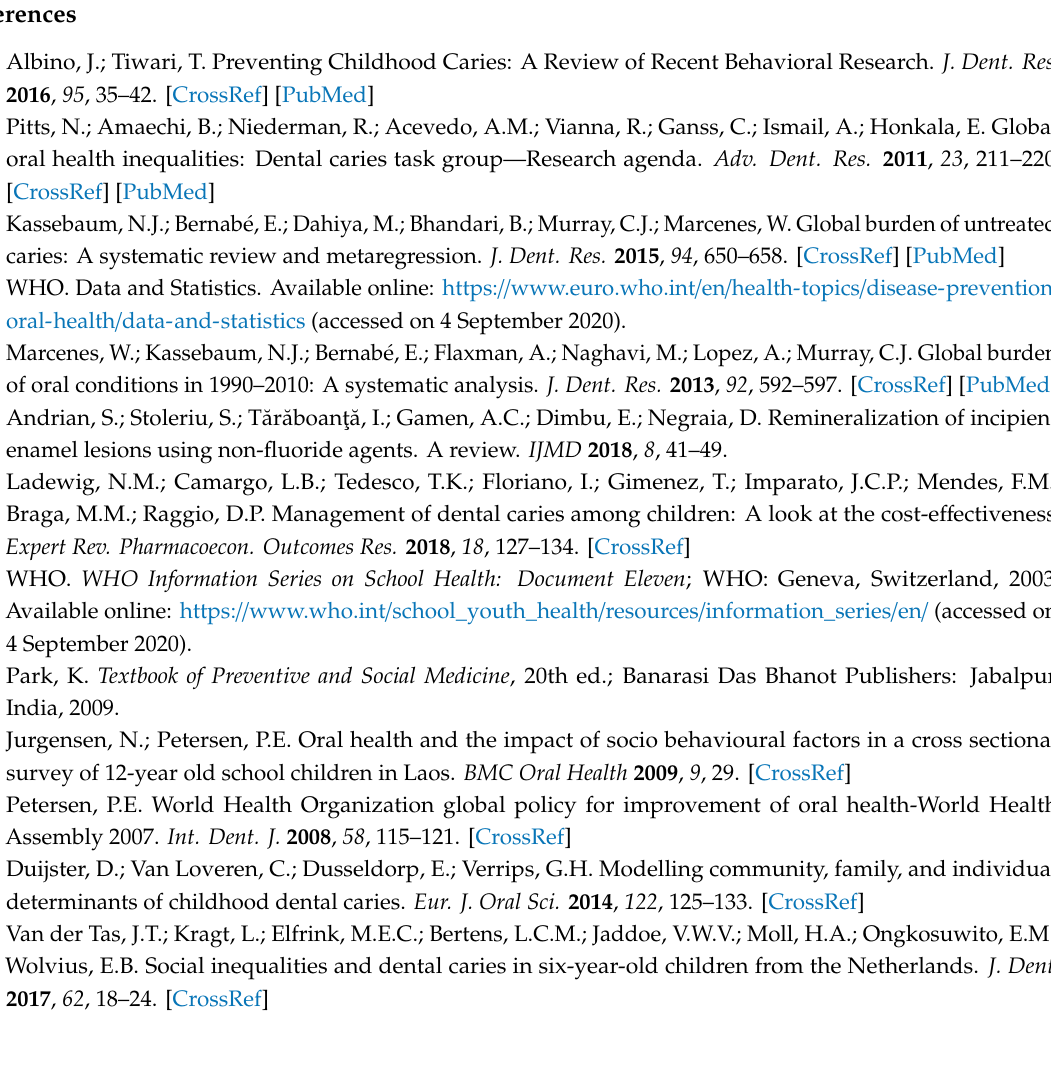
Figure S1: Logistic model analyses for both univariate and adjusted models for disease. Figure S2: Logistic model analyses for both univariate and adjusted models for oral health related quality of life (OrHQoL). Table S1: Numerosity, percentages chi-square test and chi-square proportion trend test results for disease. Table S2: Numerosity, percentages chi-square test and chi-square proportion trend test results for oral health related quality of life